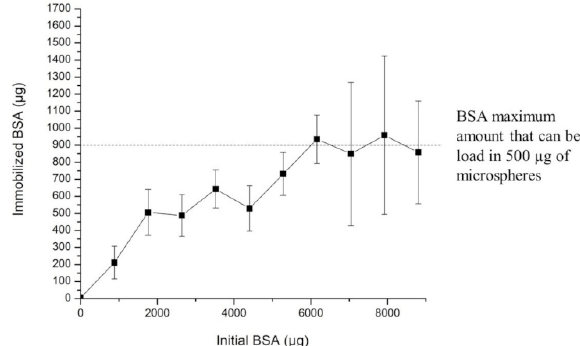
Figure 12. Different amounts of immobilized BSA are shown for different initial amounts of